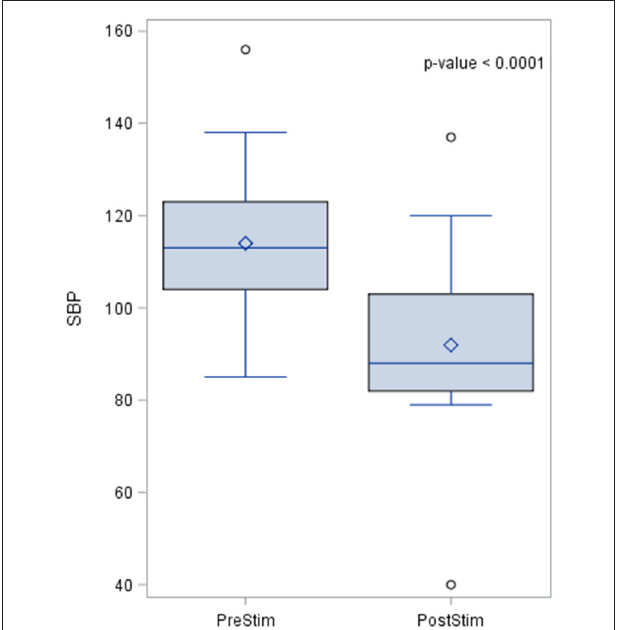
FIGURE 1 | Stimulation results- Octad probe (pilot phase). Results of pre and post stimulation for each research animal are plotted in this figure ( n These are the results of aortic arch baroreceptor stimulation with the Octad experimental probe. SBP blood pressure values are represented in mmHg.